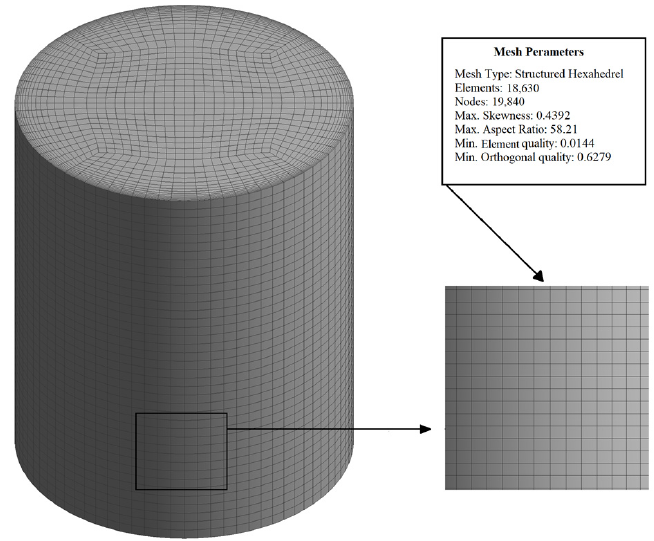
Figure 3. Three-dimensional computational geometry with hexahedral mesh.